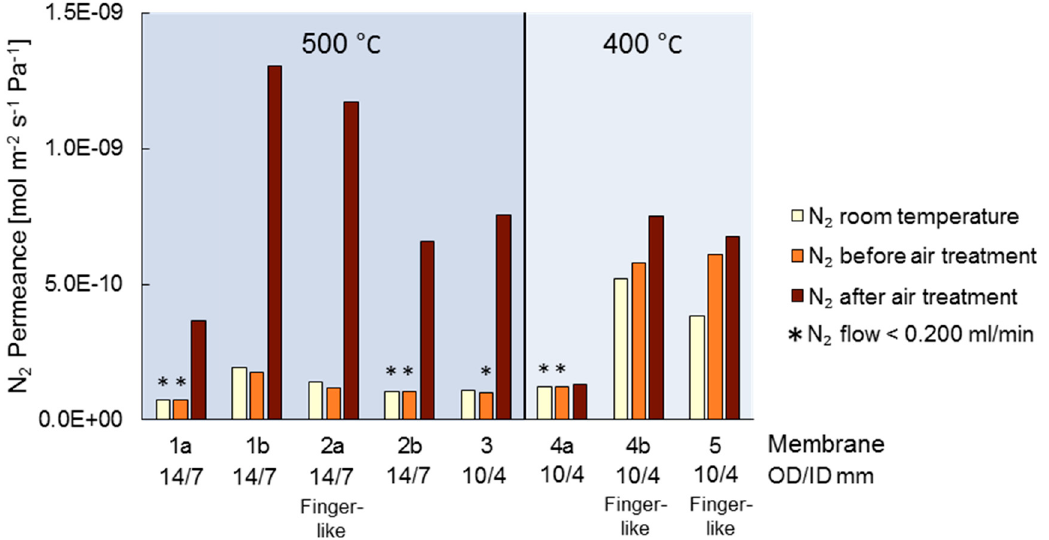
Figure 3. Nitrogen permeance before and after heating and air treatment.